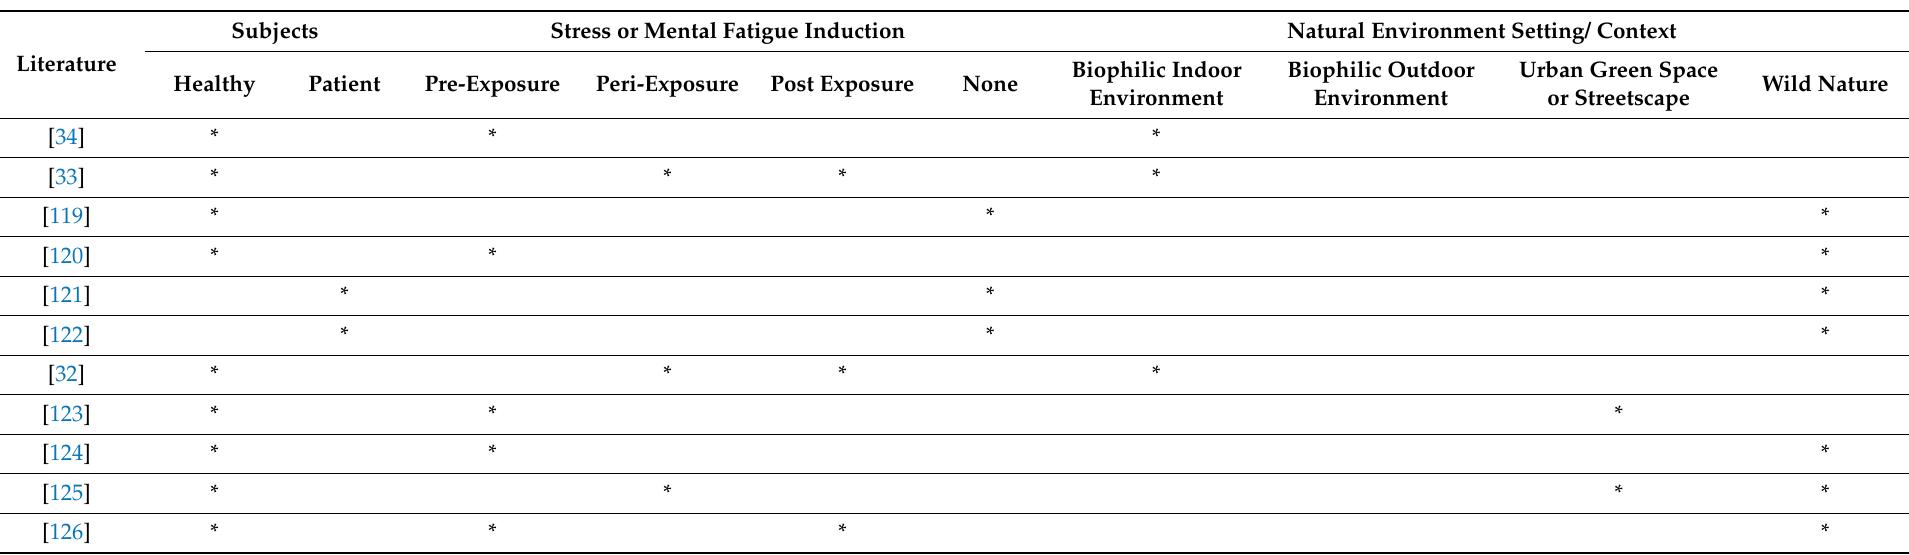
Table A3. Classification of the reviewed studies employing virtual natural environment (factors